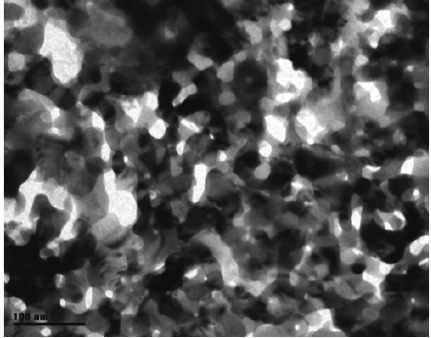
Figure 4: TEM image of orange peel activated